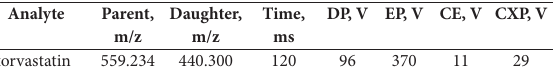
Table 5. Multiple reaction monitoring (MRM) parameters of propranolol.